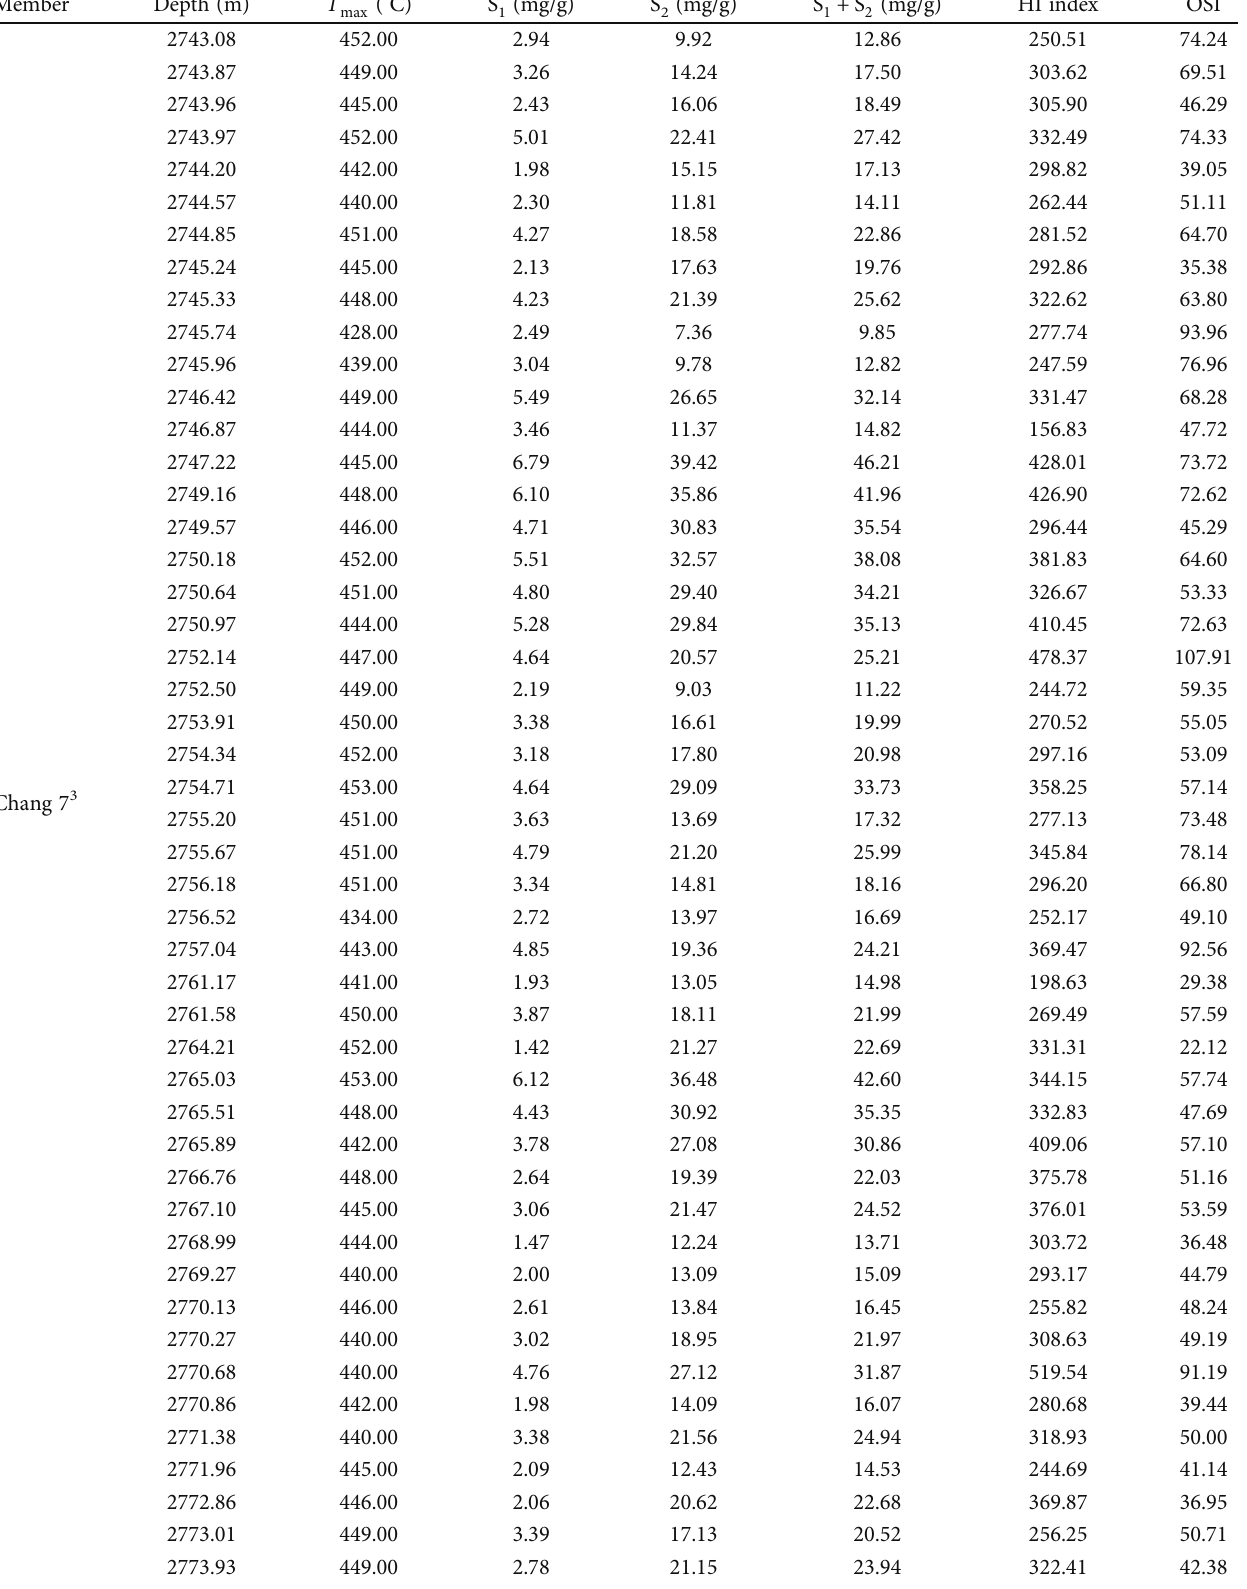
Table 1: Rock-Eval pyrolysis data of Chang 7 3 and Chang 8 intervals from well DP1 in the western Ordos Basin.